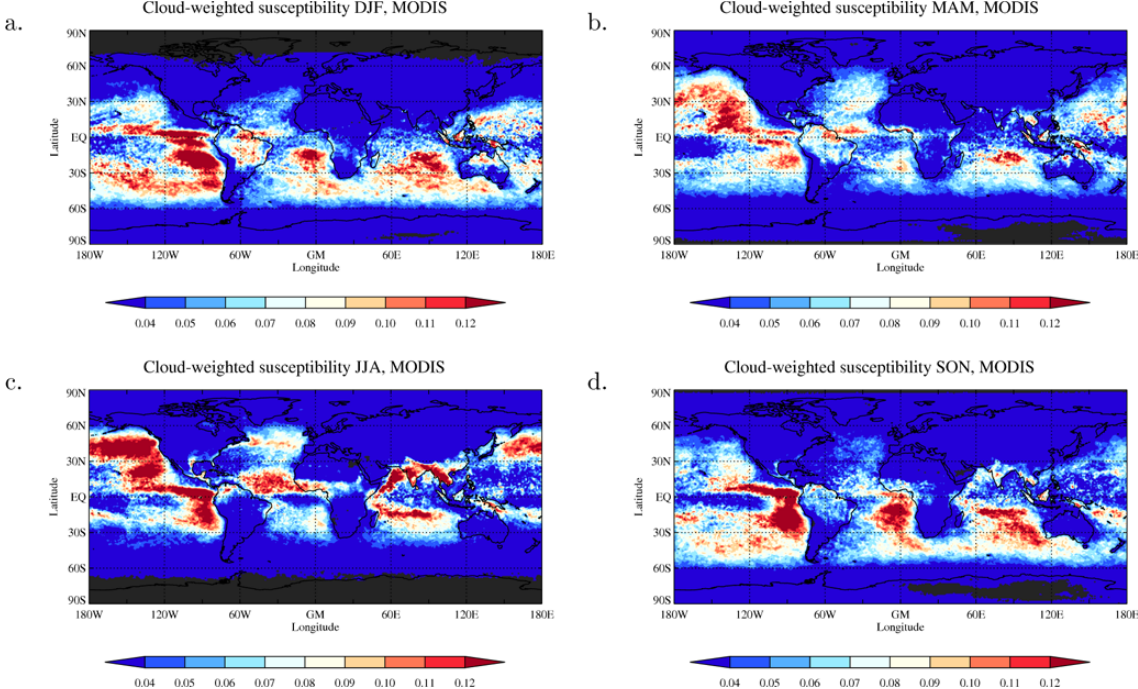
Fig. 3. Cloud-weighted susceptibility from MODIS retrievals: (a) December, January, February mean, (b) March, April, May mean, (c) June, July, August mean, (d) September, October, November